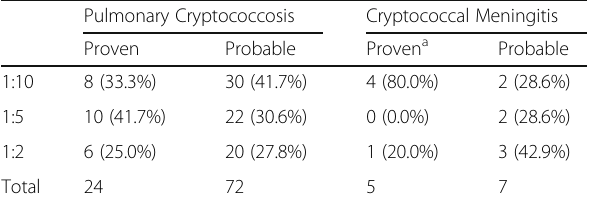
Table 2 Review of patients with proven and probable